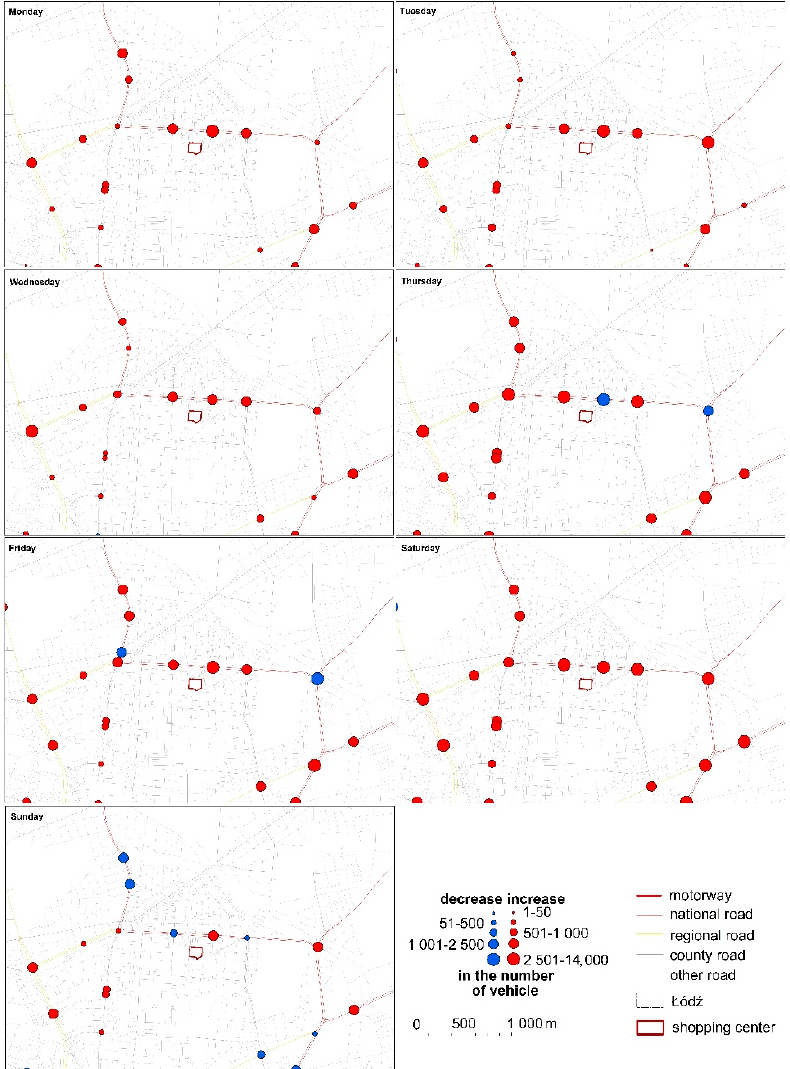
Figure 4. The average change in the number of vehicles at intersections within the researched section and its immediate vicinity between weeks with a trading and non-trading Sunday. Source: own elaboration based on the Database of Topographic Objects, OpenStreetMap, and data collected by the induction loops of the ITS in Łódź.